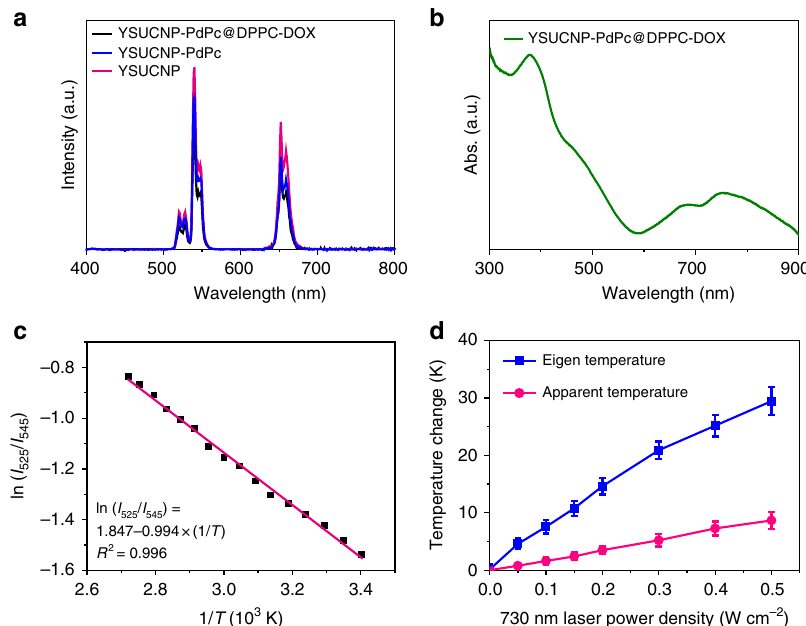
Fig. 3 Optical and temperature sensing properties of TR-UCNS. a Upconversion luminescence spectra of YSUCNP, YSUCNP-PdPc, and YSUCNP- PdPc@DPPC-DOX (TR-UCNS) in the aqueous solution with the same concentration of Er 3 + (2.5 × 10 − 5 mol l − 1 ). The excitation wavelength of upconversion luminescence is 980 nm. b Absorption spectrum of TR-UCNS. c A plot of ln ( I 525 / I 545 ) versus 1/ T to calibrate the thermometric scale for TR- UCNS. I 525 and I 545 indicate the intensities of UCL emission of the 2 H 11/2 → 4 I 15/2 and 4 S 3/2 → 4 I 15/2 transitions, respectively. d Elevation of apparent temperature (A.T.) and eigen temperature (E.T.) of TR-UCNS (0.5 mg ml − 1 ) in aqueous dispersion under irradiation with a 730 nm laser at various power densities. Average value of A.T. and E.T. under different time points were given based on three times measurements. Error bars were de fi ned as s.d. ( n =